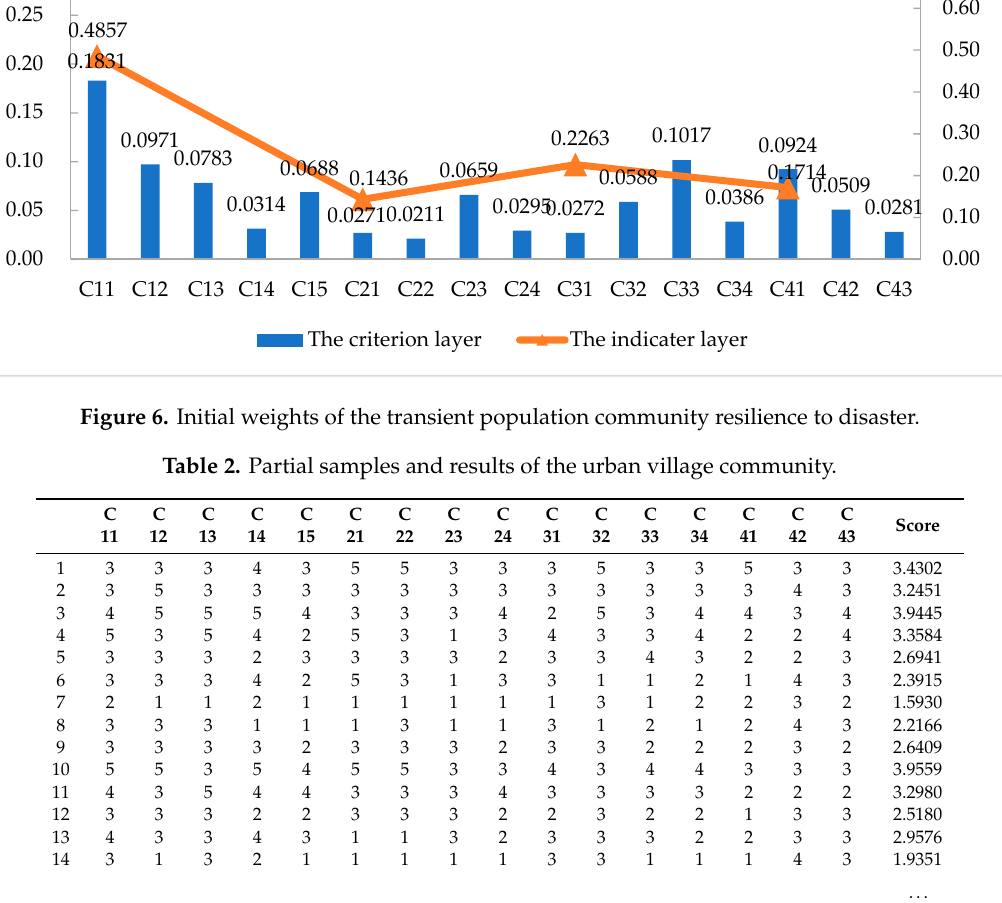
Table 2. Partial samples and results of the urban village community.